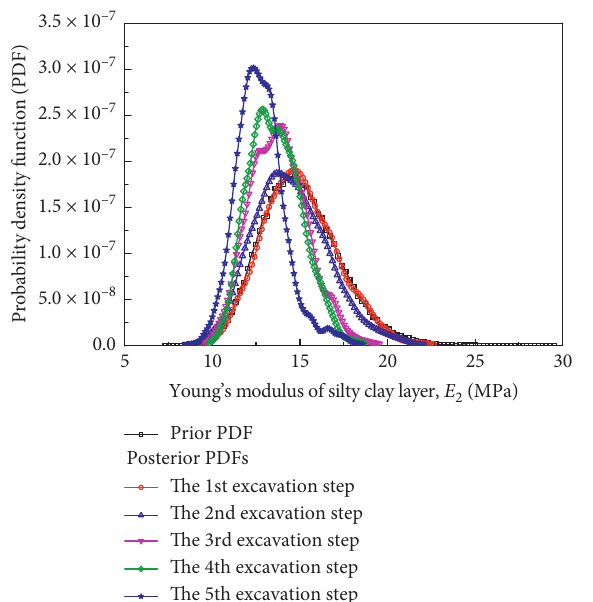
Figure 7: Comparison of the posterior PDFs of Young’s modulus of silty clay layer for different excavation steps.